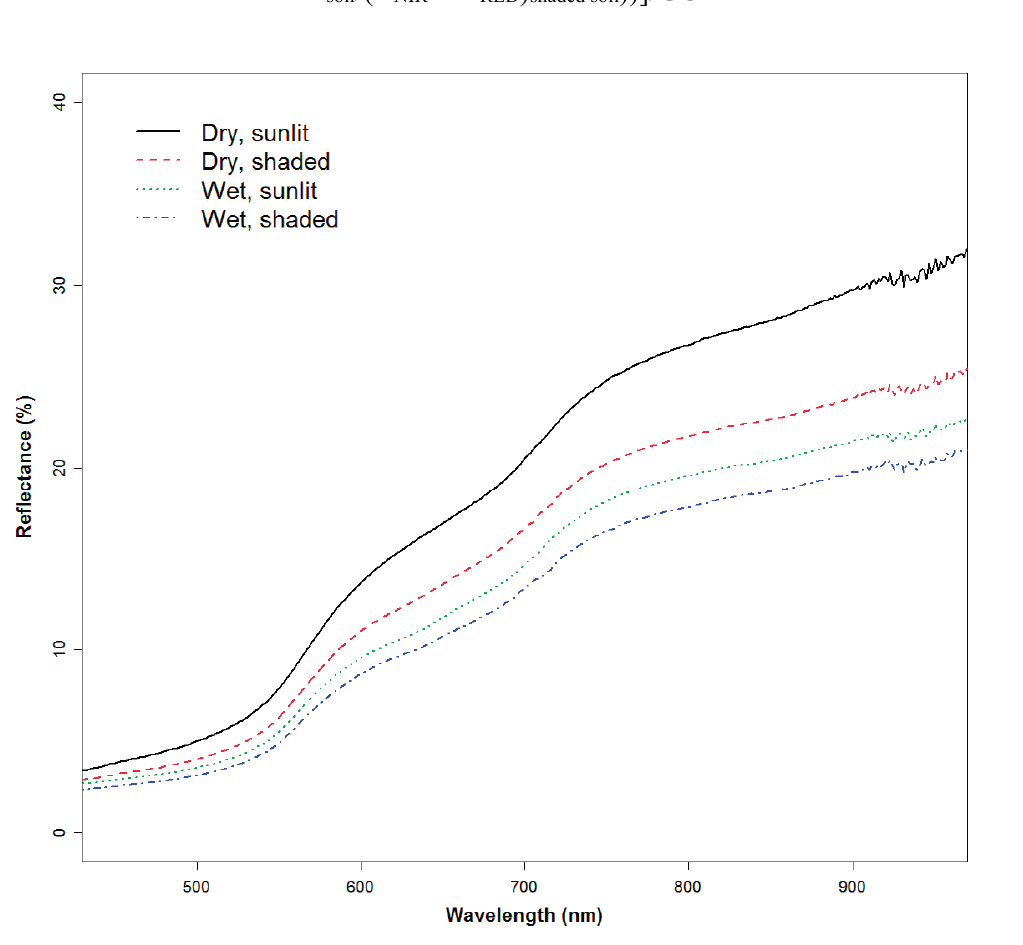
Figure 2. Soil reflectance under different soil moisture conditions and solar illumination. Reflectance for different soil conditions is presented in Figure 2 [30]. The soil reflectance measurements were taken using a GER 1500 spectroradiometer on Pullman clay loam (thermic Torrertic Paleustolls) soil. For the wet soil reflectance measurement, 1 L of water was applied to saturate the soil surface. Dry soil that is sunlit or shaded within the sensor’s field of view has reflectance that linearly increase from red to NIR wavelengths, even though the spectrum of shaded soil is slightly lower than that for sunlit, dry soil. Likewise, sunlit or shaded wet soil has a similar increasing pattern. In a situation where the difference of (R NIR – R RED ) between two soil conditions is maximum, which can occur when a fraction of (1 – GC) is wet and shaded, while the remaining fraction is dry and sunlit. In this situation, the value of (R NIR – R RED ) dry,sunlit soil is 0.11 while (R NIR – R RED ) wet,shaded soil is 0.08, indicating that the difference between these two values should be small. Therefore, we adopt the approach of Jiang et al. [45] who assume that (R NIR – R RED ) sunlit soil ≈ (R NIR – R RED ) shaded soil . Figure 2